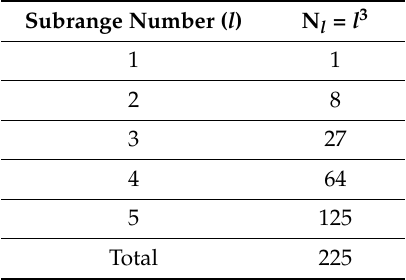
Table 3. Number of light pulses necessary for each